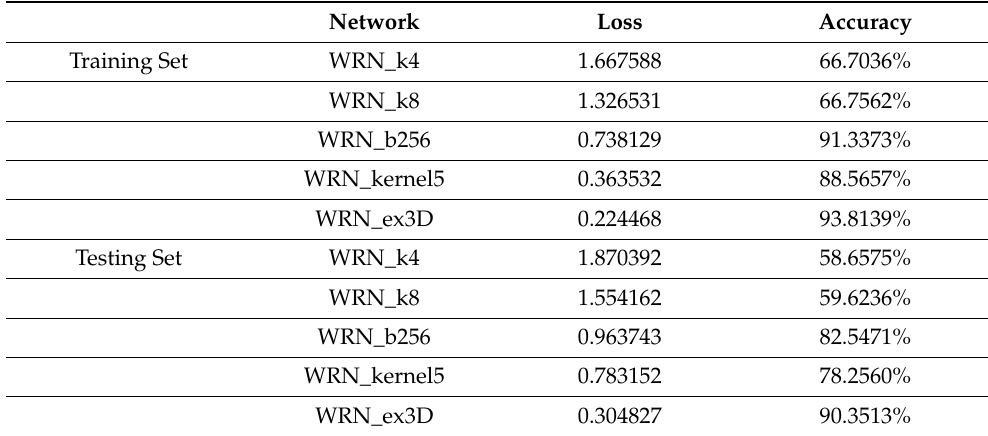
Table 7. Testing results under the condition where the samples were randomly distributed between training and testing sets at a 7:3 ratio.